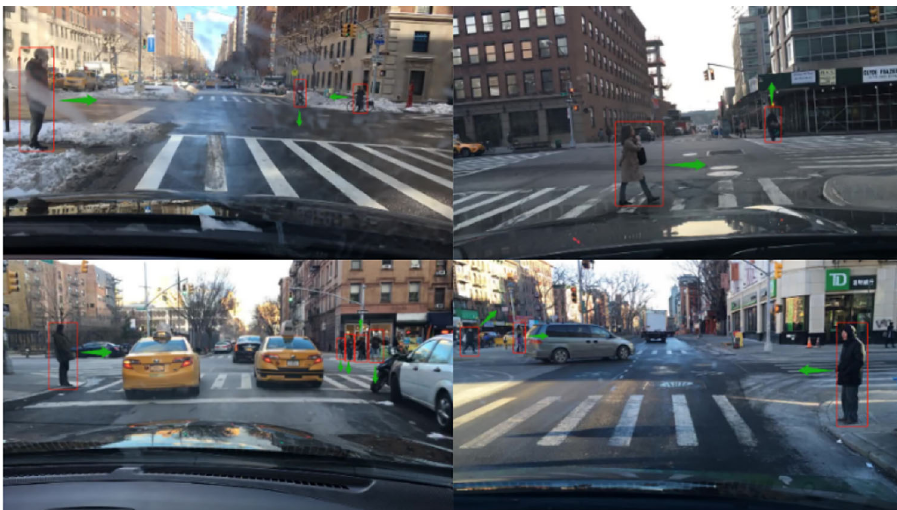
Fig. 1 Illustration of pedestrian orientation classification in traffic